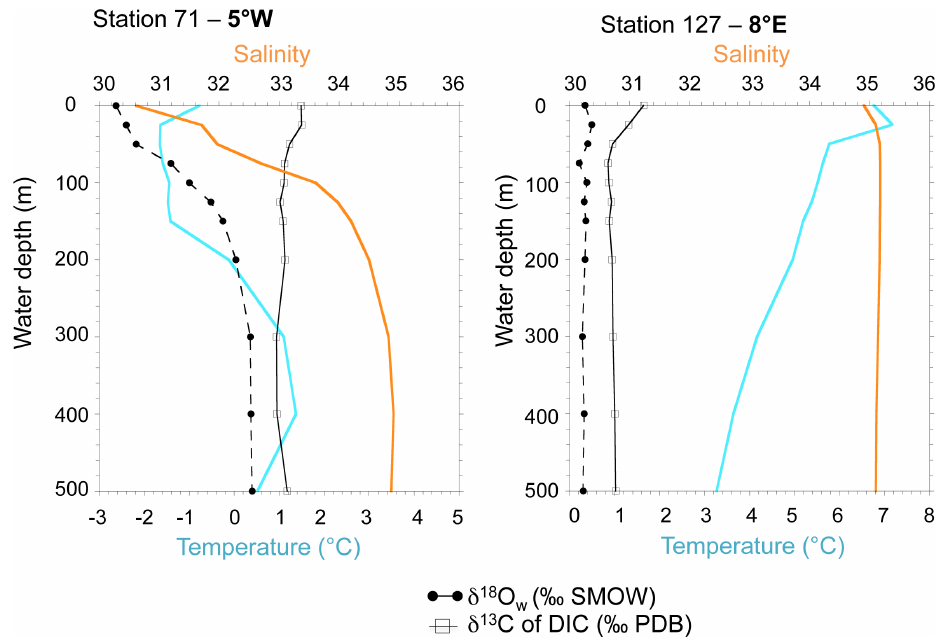
Figure 4. Salinity, temperature, δ 18 O (‰ SMOW) and δ 13 C DIC (‰ PDB) profiles of the upper 500m of the water column from the west- ernmost and easternmost stations sampled along a transect at 78 temperatures and isotope